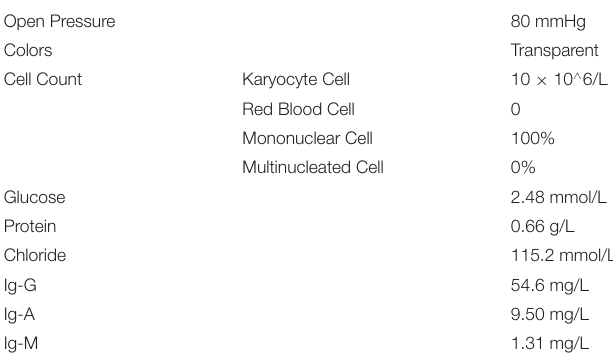
TABLE 1 | Cerebrospinal fluid